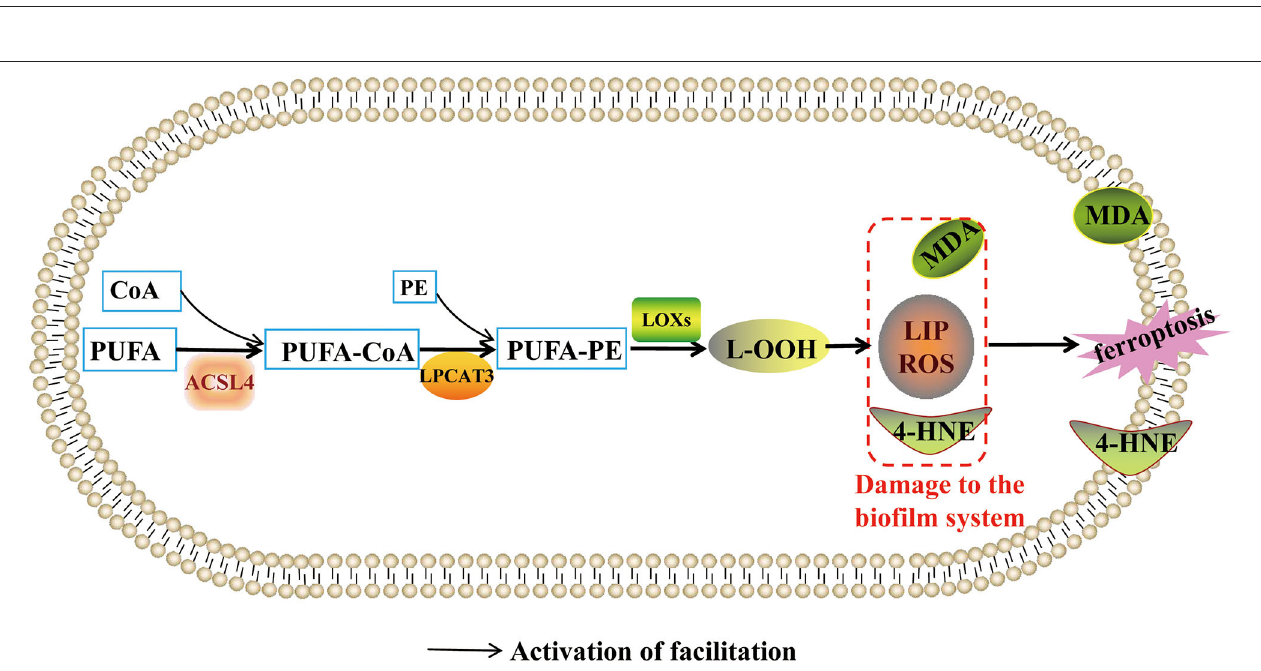
FIGURE 2 | Regulation of abnormal lipid metabolism on ferroptosis. This figure summarizes the regulatory effect of lipid metabolism on ferroptosis. The black arrow represents the activation of the regulatory role of lipid metabolism.